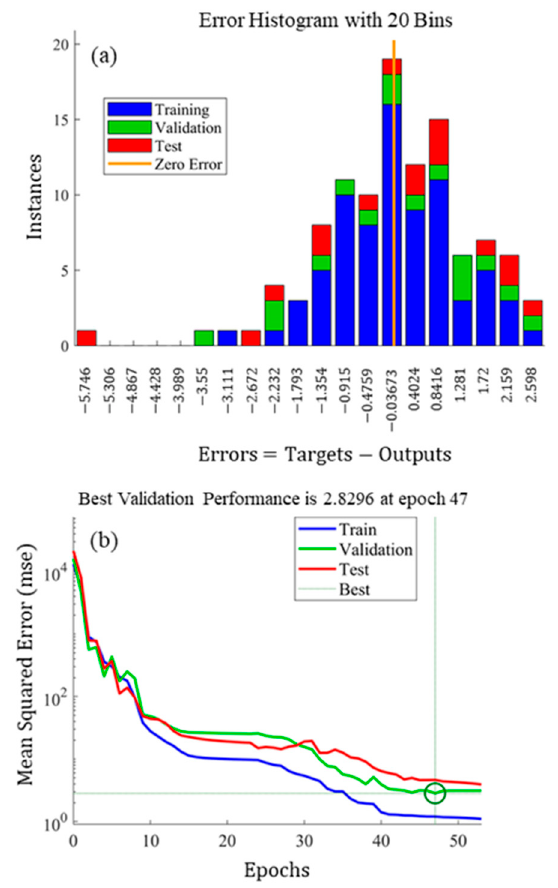
Figure 8. The performance of the ANN on the training, validation, and test datasets are depicted in terms of ( a ) the error histogram and ( b ) the MSE during various training cycles.